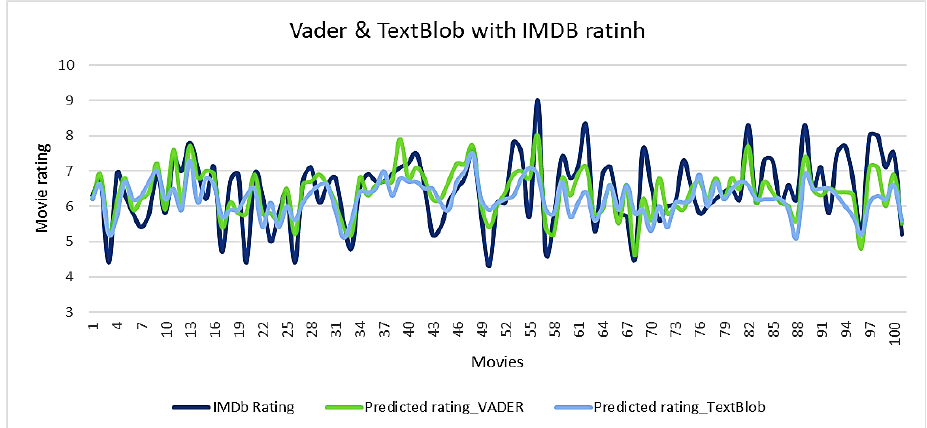
Figure 5. Comparison between Predicted rating by Vader and TextBlob and IMDb rating.